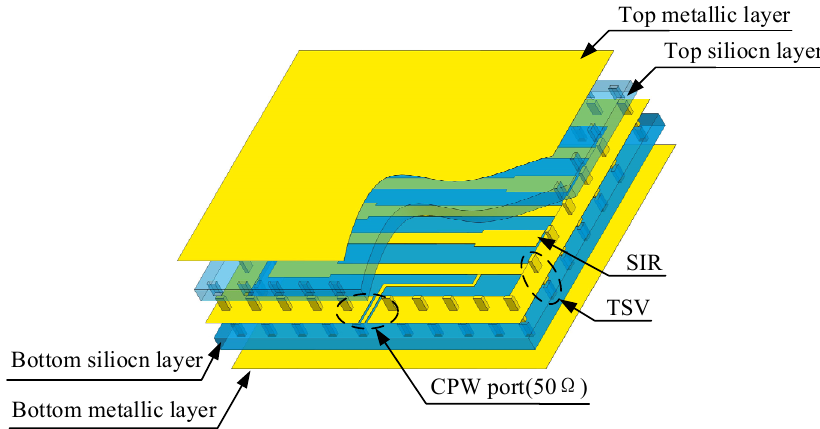
Figure 1. The structure of the double-layer silicon-based interdigital filter.